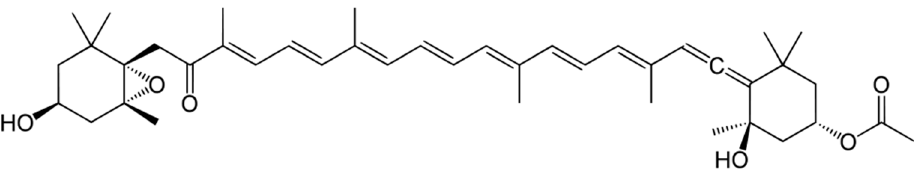
Figure 9. Chemical structure of Fucoxanthin.